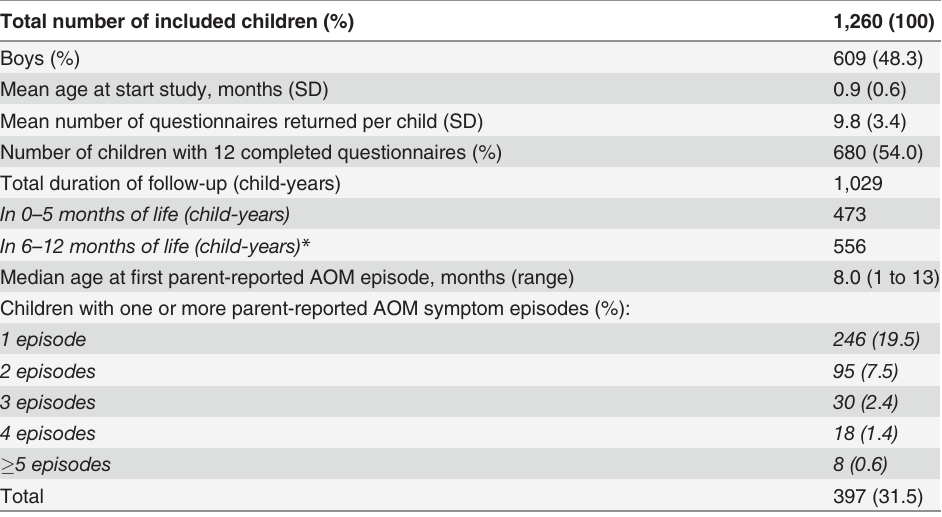
Table 1. Characteristics of the 1,260 included